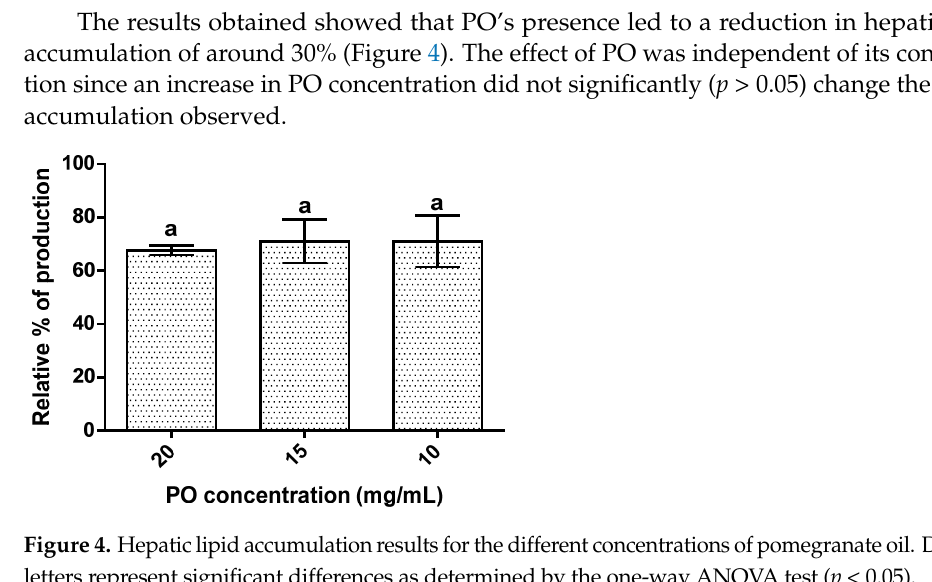
Figure 4. Hepatic lipid accumulation results for the different concentrations of pomegranate oil. Different letters represent significant differences as determined by the one-way ANOVA test ( p < 0.05).